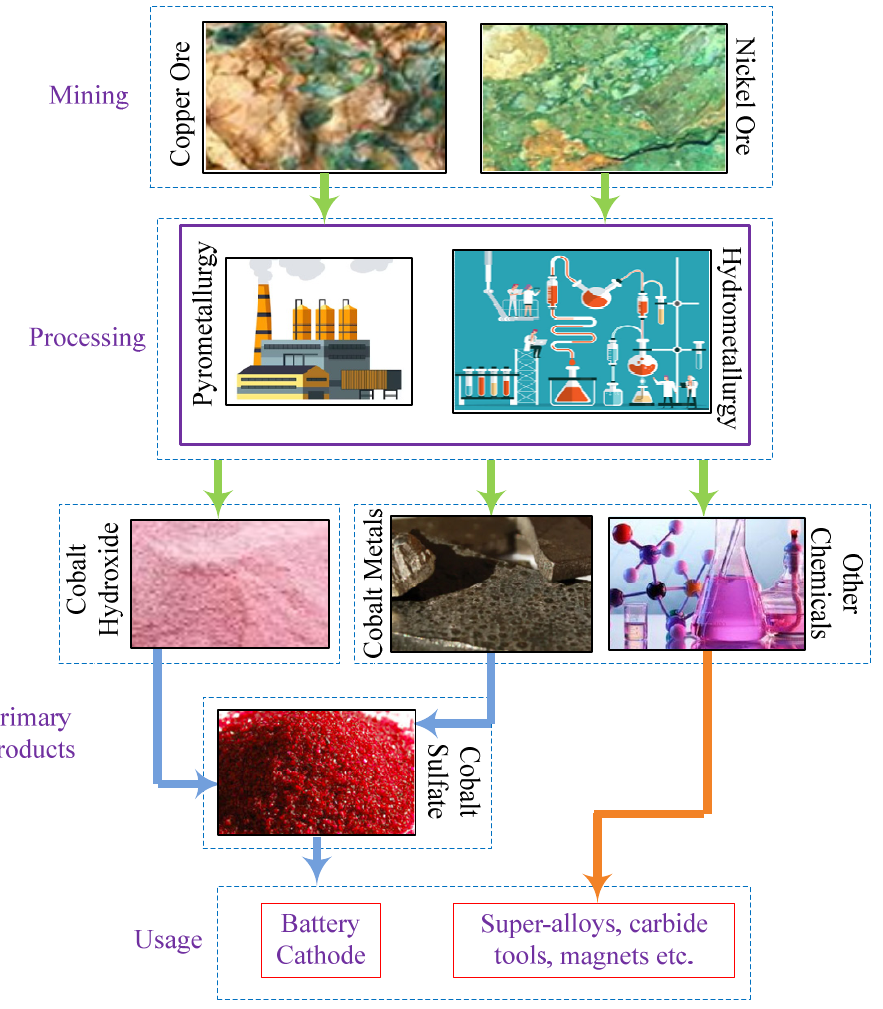
Figure 12. Supply chain of